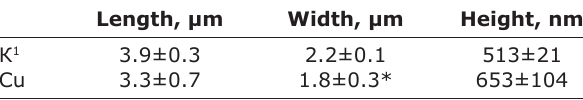
Table-1: Morphological characteristics of B. licheniformis 7038.